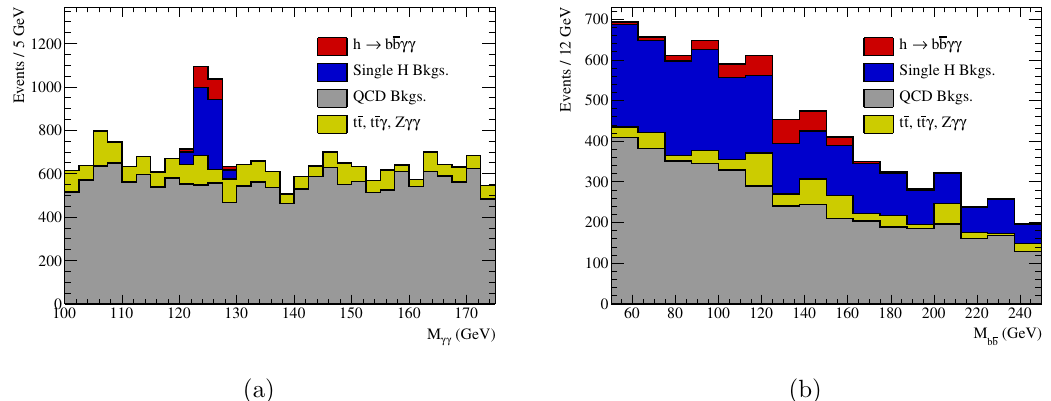
Figure 5. Stacked histograms showing the contribution of events from the signal (red) and each background category (single Higgs production in blue, t (cid:22) t , t (cid:22) t(cid:13) and Z(cid:13)(cid:13) in yellow, and QCD back- grounds in grey) passing every cut except the cut on m (cid:13)(cid:13) (top) and m detector scenario. The single Higgs background shows an additional peak at m to the contribution from the Z ( b (cid:22) b ) h ( (cid:13)(cid:13) ) background.